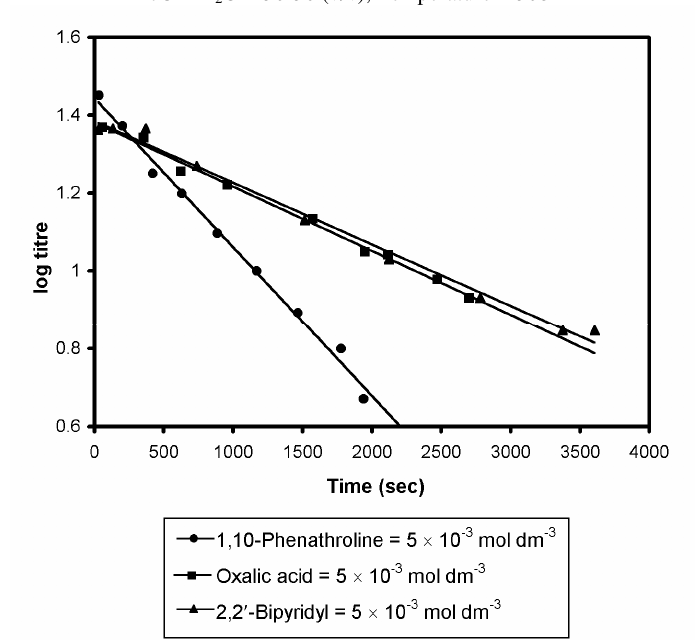
Figure 3 . Catalytic activities of different